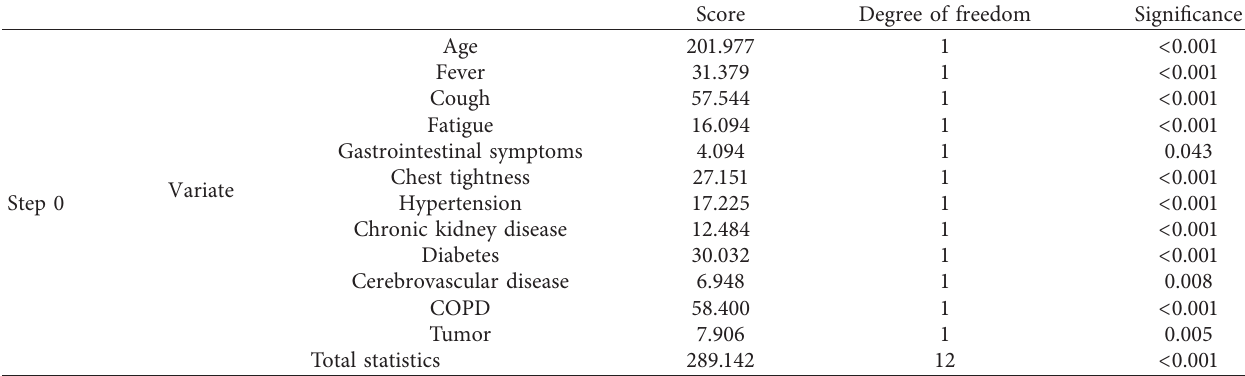
Table 6: Comparison of clinical symptom indices between common and severe COVID-19 patients after removing complications.